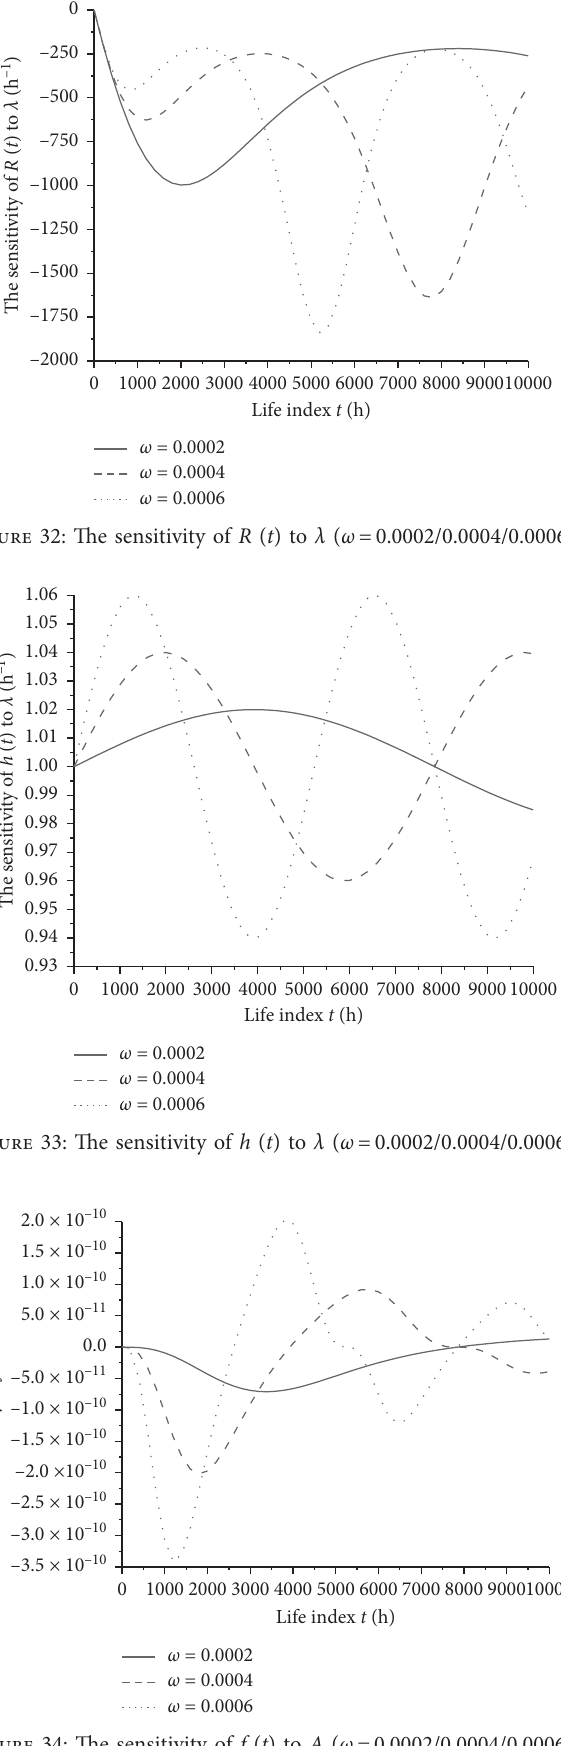
Figure 34: The sensitivity of f ( t ) to A ( ω �